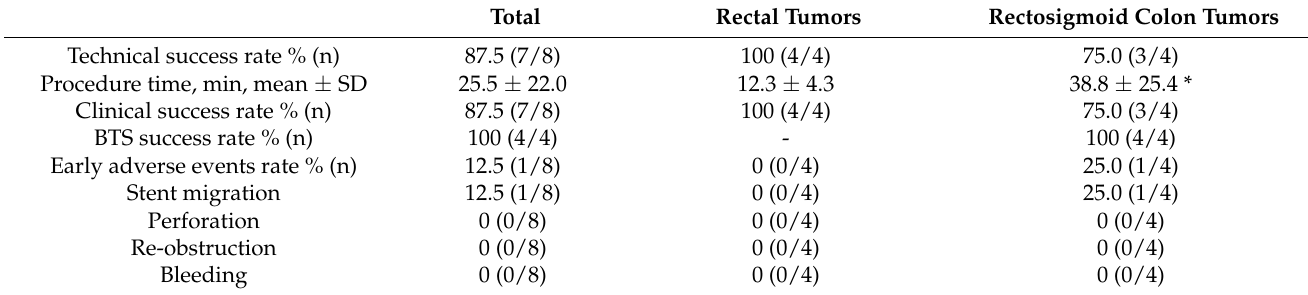
Table 2. Short-term outcomes of the newly developed proximal-release SEMS placement. Total Rectal Tumors Rectosigmoid Colon Tumors